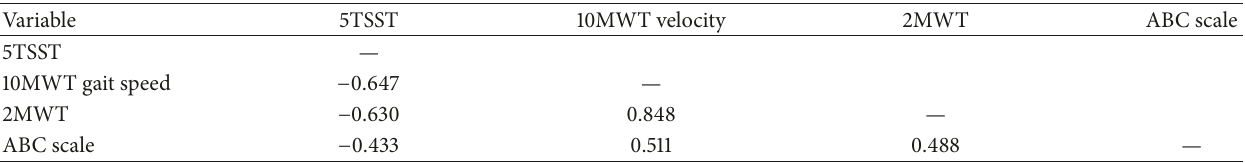
Table 5: Interitem correlations between outcome measures.